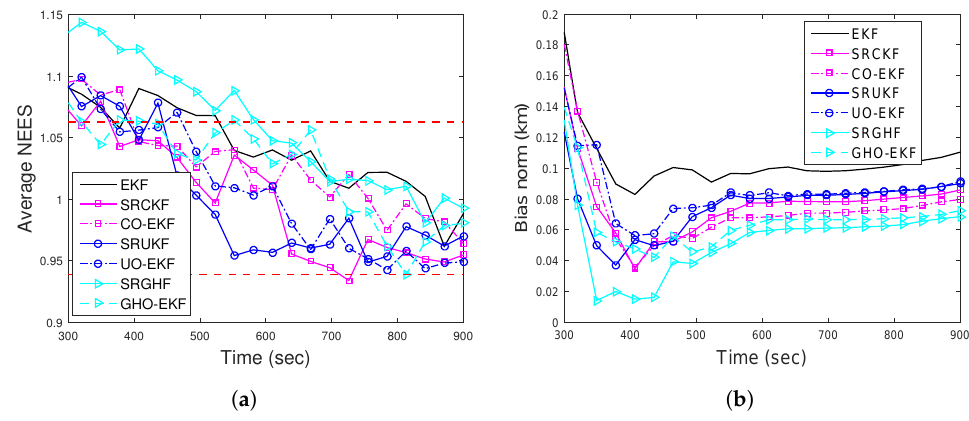
Figure 11. ( a ) ANEES; ( b ) position bias norm of the BOT for Scenario